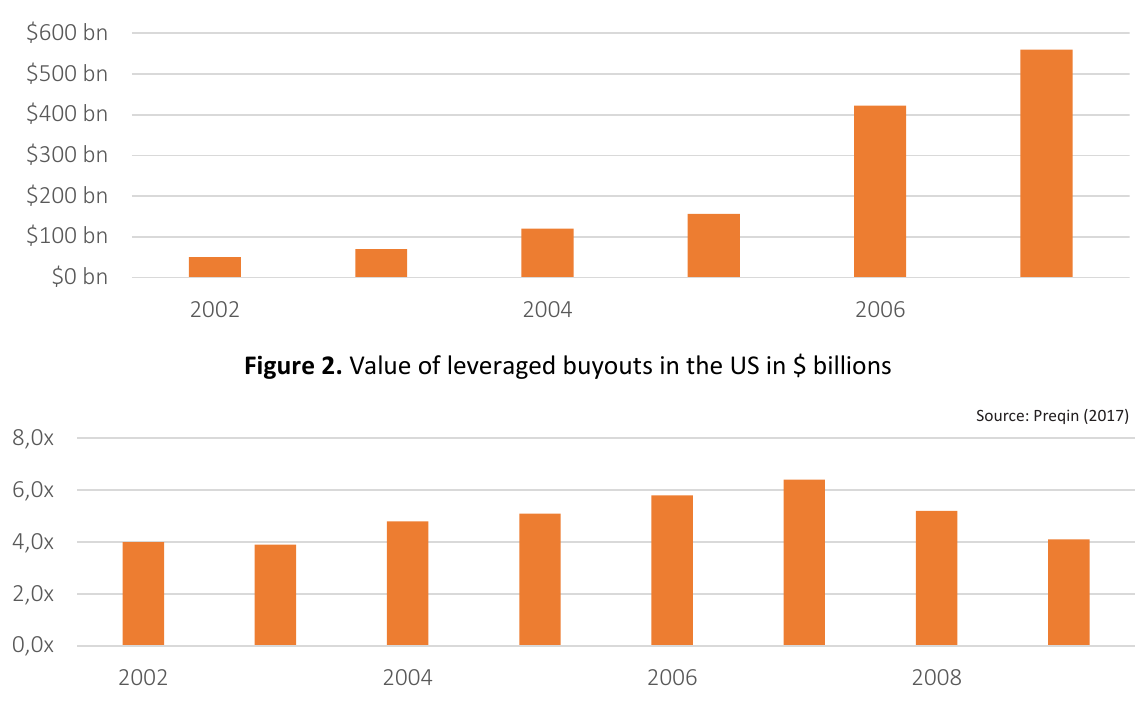
Figure 3. Debt to Ebitda ratios for leveraged buyouts in the